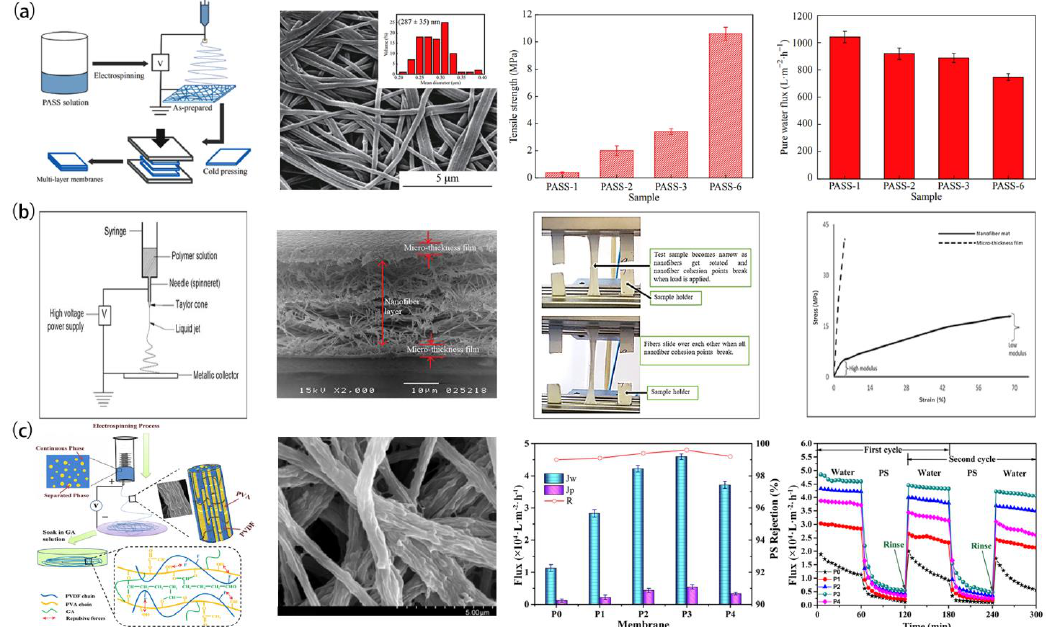
Figure 3. Preparation process, microstructure, and properties of MF membranes: ( a ) PASS mem- brane. Reprinted with permission from Ref. [47]. Copyright 2019 Springer Nature. ( b ) PVC mem- brane. Reprinted with permission from Ref. [48]. Copyright 2020 SAGE Publications. ( c ) PVDF/PVA membrane. Reprinted with permission from Ref. [49]. Copyright 2019 John Wiley and Sons, Inc.